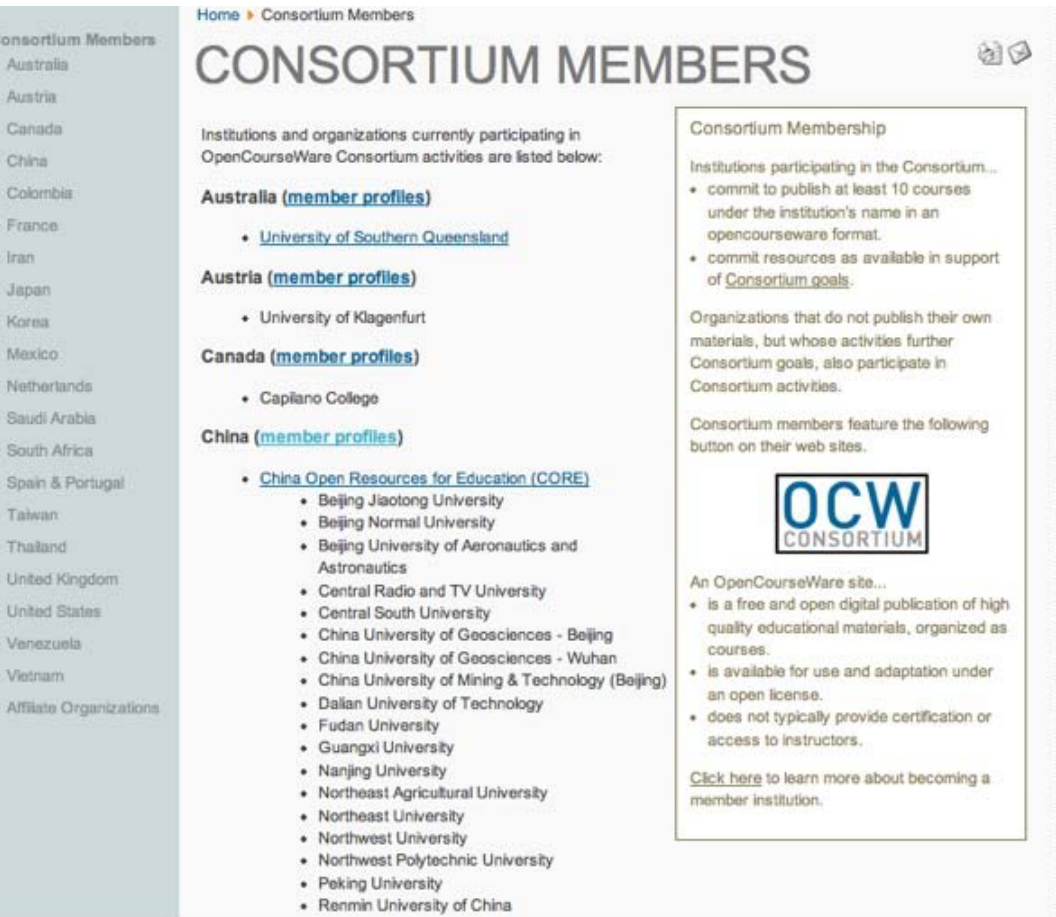
Figure 1. Image of the top portion of the OCW Consortium page of